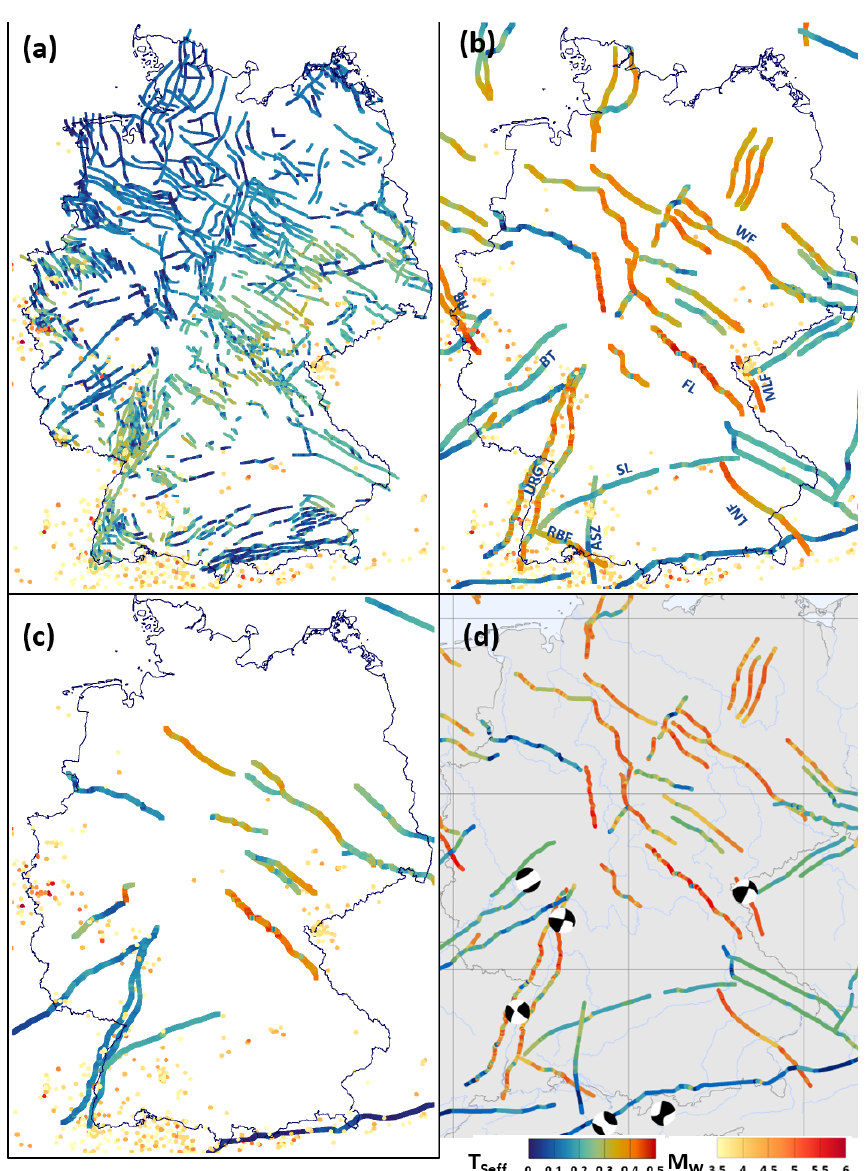
Figure 12. Seismic events with M w > 3 . 5 color-coded by their moment magnitude (yellow to red) displayed on horizontal cross sections through the fault sets color-coded by T Seff (hydrostatic pore pressure) at 8km depth. (a) Vertical fault set; (b) Andersonian fault set; (c) Semi- realistic fault set. The color bars of T seff and M w apply to (a) – (d) ; (d) Andersonian fault set with fault plane solutions from the GFZ